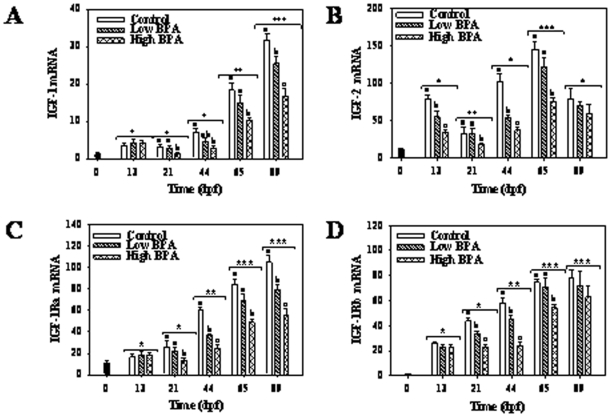
Impact of bisphenol A (BPA) on insulin-like growth factors (IGFs) and their receptors gene expressions.Temporal changes in IGF-1 (A) and IGF-2 (B) and IGF-1 receptor a (IGF-1 Ra; C) and b (IGF-I Rb; D) mRNA abundances in rainbow trout embryos in response to BPA treatment. See the Fig. 2 legend for experimental details. Maternal transcript levels were measured in freshly fertilized eggs and represented as 0-dpf (dark colored bar). Two-way ANOVA was used to determine the effect of time, treatment and interaction effects on the transcript levels during development (Bonferonni post hoc test; p<0.05). Different letters represent differences between treatments at each time point. Asterisk (*) represent effect of time on mRNA abundances. All values represent mean + SEM (n = 7).